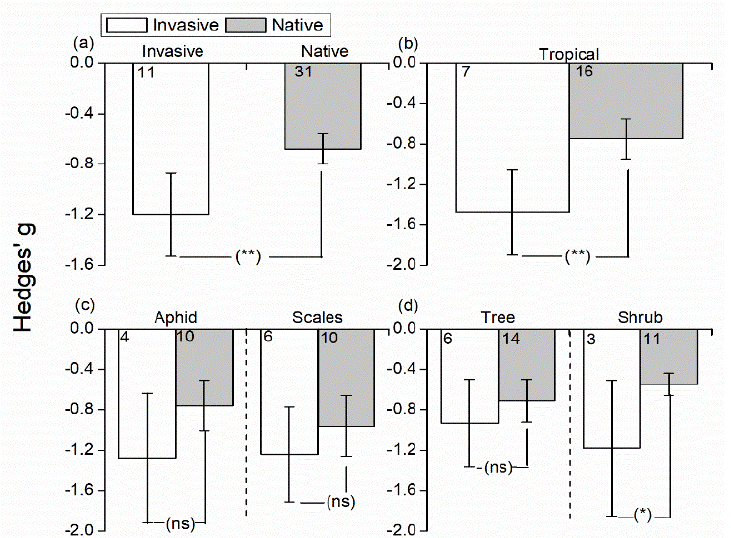
Figure 3. Mean effect size (Hedges’ g) and 95% confidence interval of the effect of exclusion invasive or native ants on Hemiptera abundance ( a ) under different climatic zones ( b ), Hemiptera type ( c ), and plant growth form ( d ). Sample sizes for each category are shown in box. * p < 0.05, ** p < 0.01, “ns” not significant.